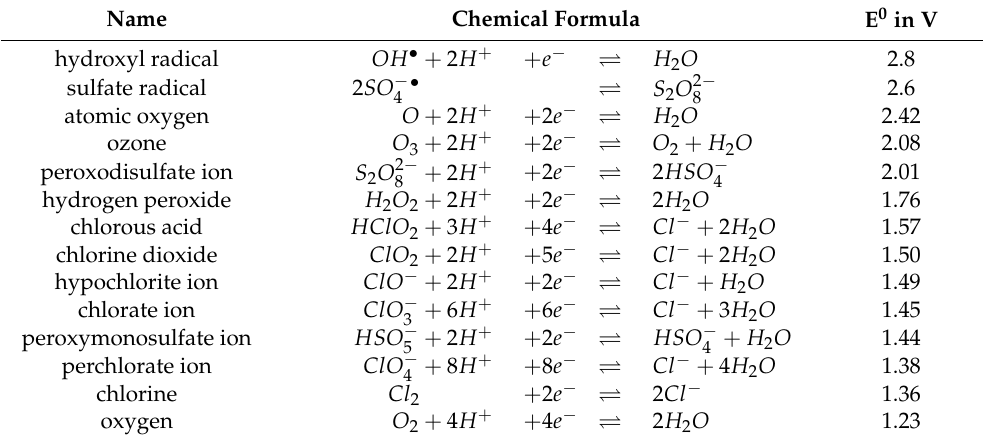
Table 1. Standard electrode potentials of selected compounds in sulfuric acid electrolytes (data from